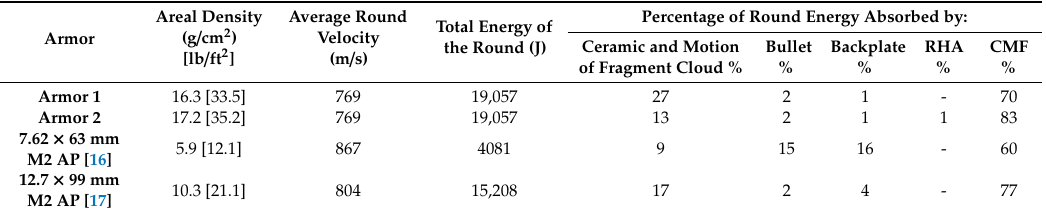
Table 3. Percentage of energy absorbed by a CMF armor each layer for partial penetration (PP) impacts against multiple sized rounds.